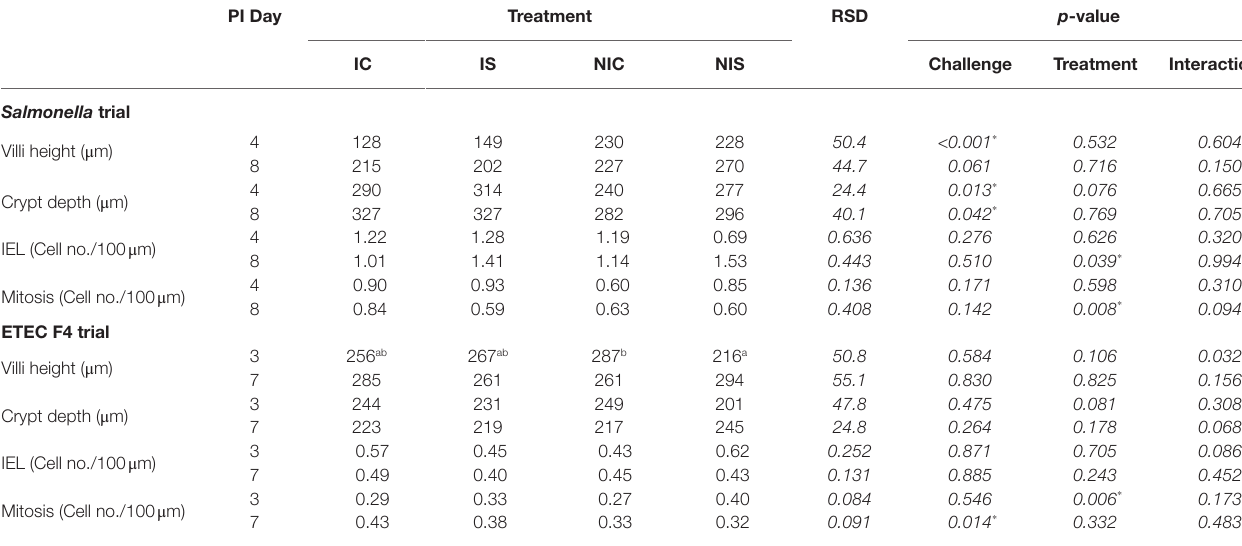
TABLE 6 | Effects of treatments on histomorphological parameters on days 4 and 8 ( Salmonella trial) and 3 and 7 (ETEC F4 trial) post-inoculation. PI Day Treatment RSD p -value IC IS NIC NIS Challenge Treatment